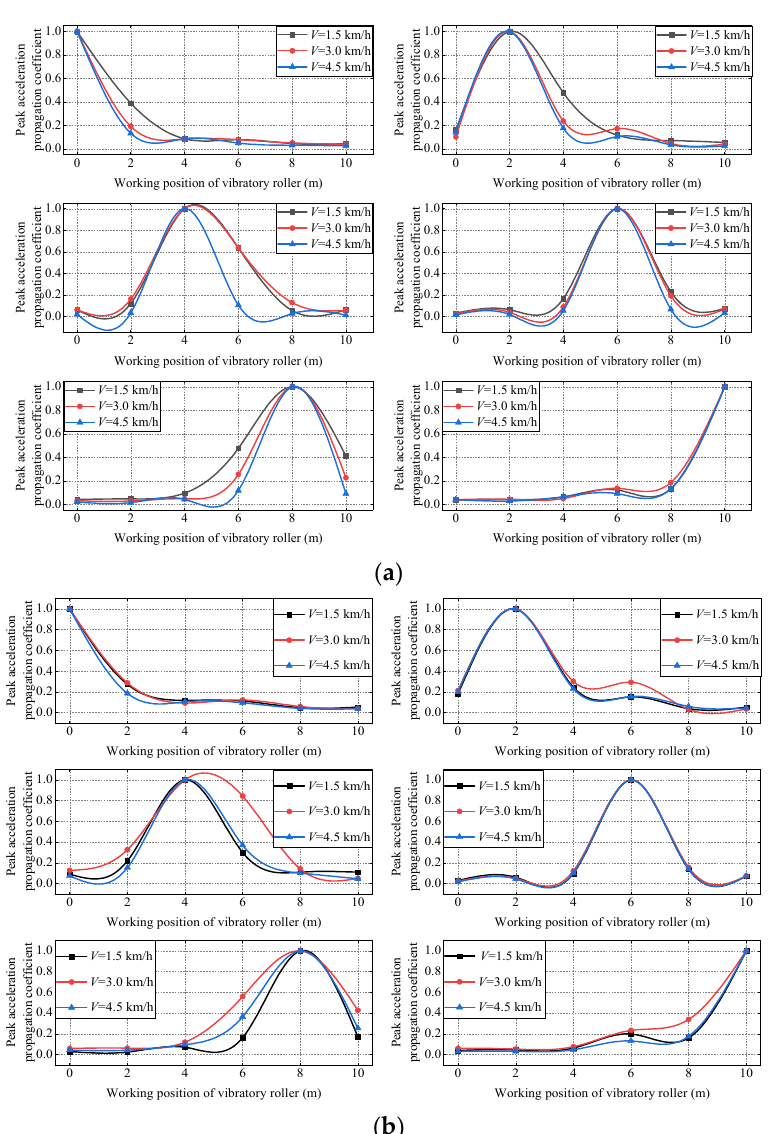
Figure 9. Propagation coefficient of peak acceleration of vibrating roller at different speeds. ( a ) Uncompacted soil. ( b ) Compacted soil.